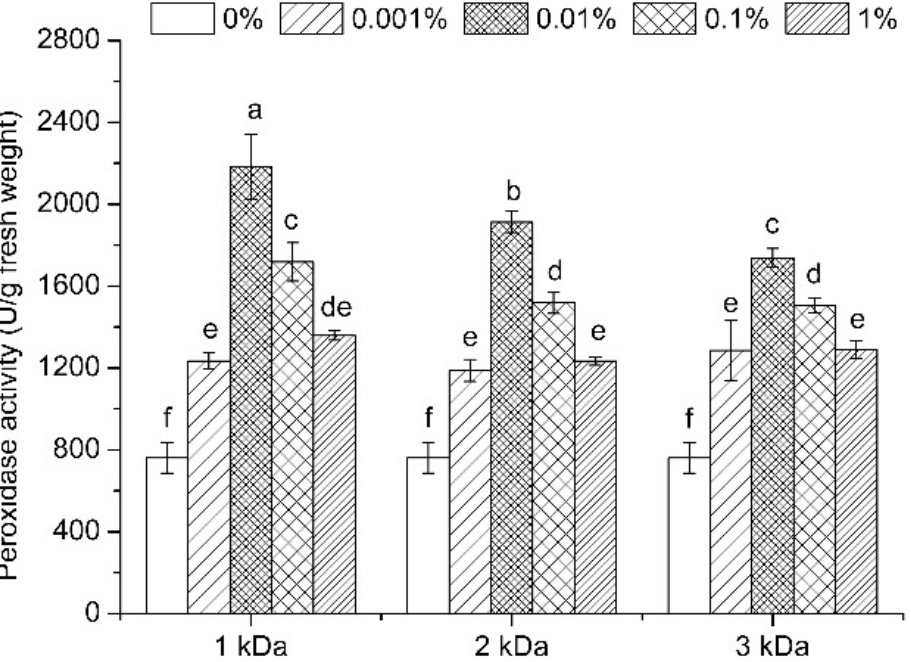
Figure 7. Peroxidase activity of soybean sprouts under different chitooligosaccharide treatments. The treatments were conducted with chitooligosaccharides of three molecular weights (1, 2, and 3 kDa) at four different concentrations (0.001 to 1%). The control treatment (0%) included the same solutions without chitooligosaccharides. Vertical bars represent the standard error of three replicates. Different letters indicate statistically significant difference ( p < 0.05).